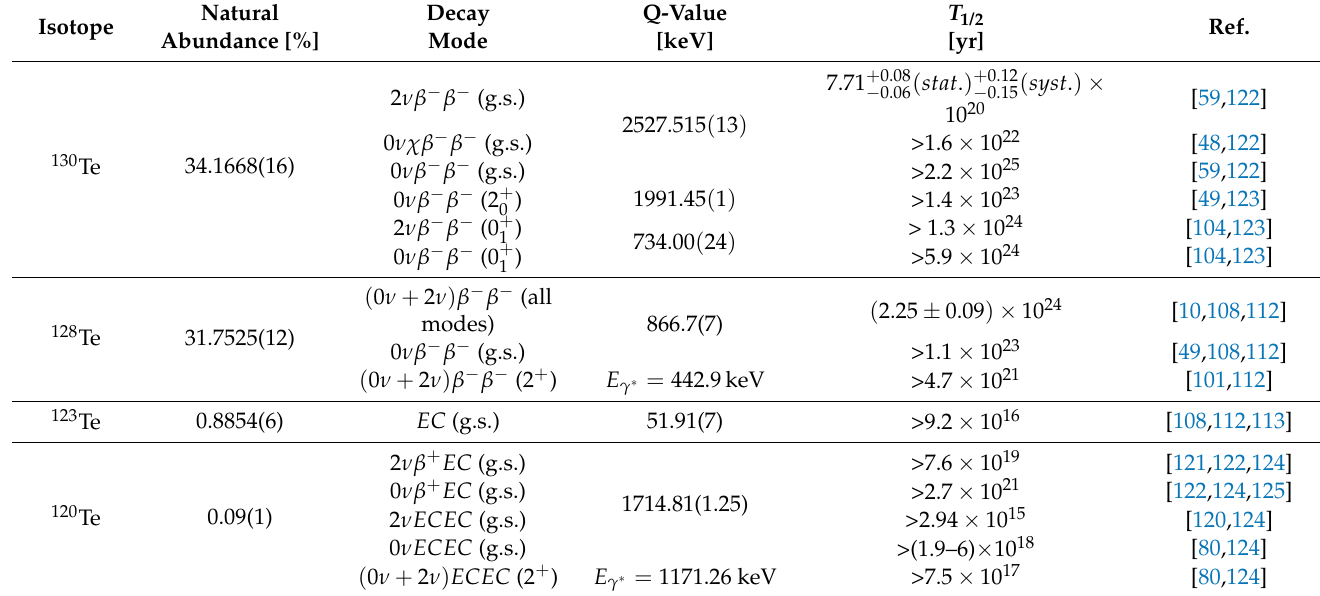
Table 1. The most stringent results on known decay modes of Te isotopes are listed below. Positive results are quoted as central value, statistical and systematical uncertainty, in this order. Regarding 120 Te double electron capture decay, the available energy depends on the specific shells involved: the binding energy is 29.2 keV for the K shell, 4.46, 4.15 and 3.93 keV for the L shell. For the 0 ν mode to the ground state, we report a range of half life limits, resulting from the possible combinations of the shells considered in [80]: K 1 K 2 ,K 1 L 2 and L 1 L 2 . For the decay to the first excited state of 120 Sn we indicate the energy of the detected gamma-ray.